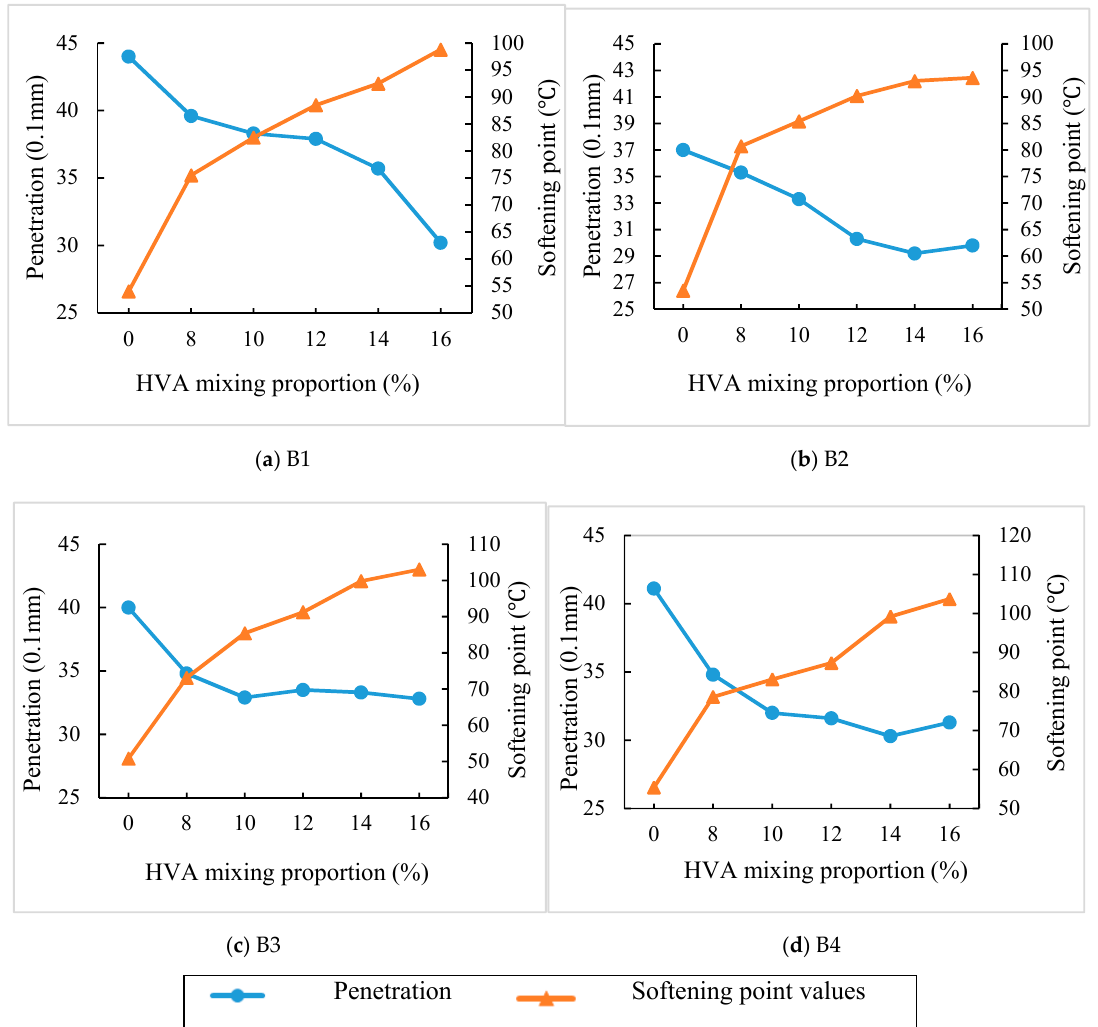
Figure 3. Penetration, softening point values of four HVMA with different HVA mixing proportion.